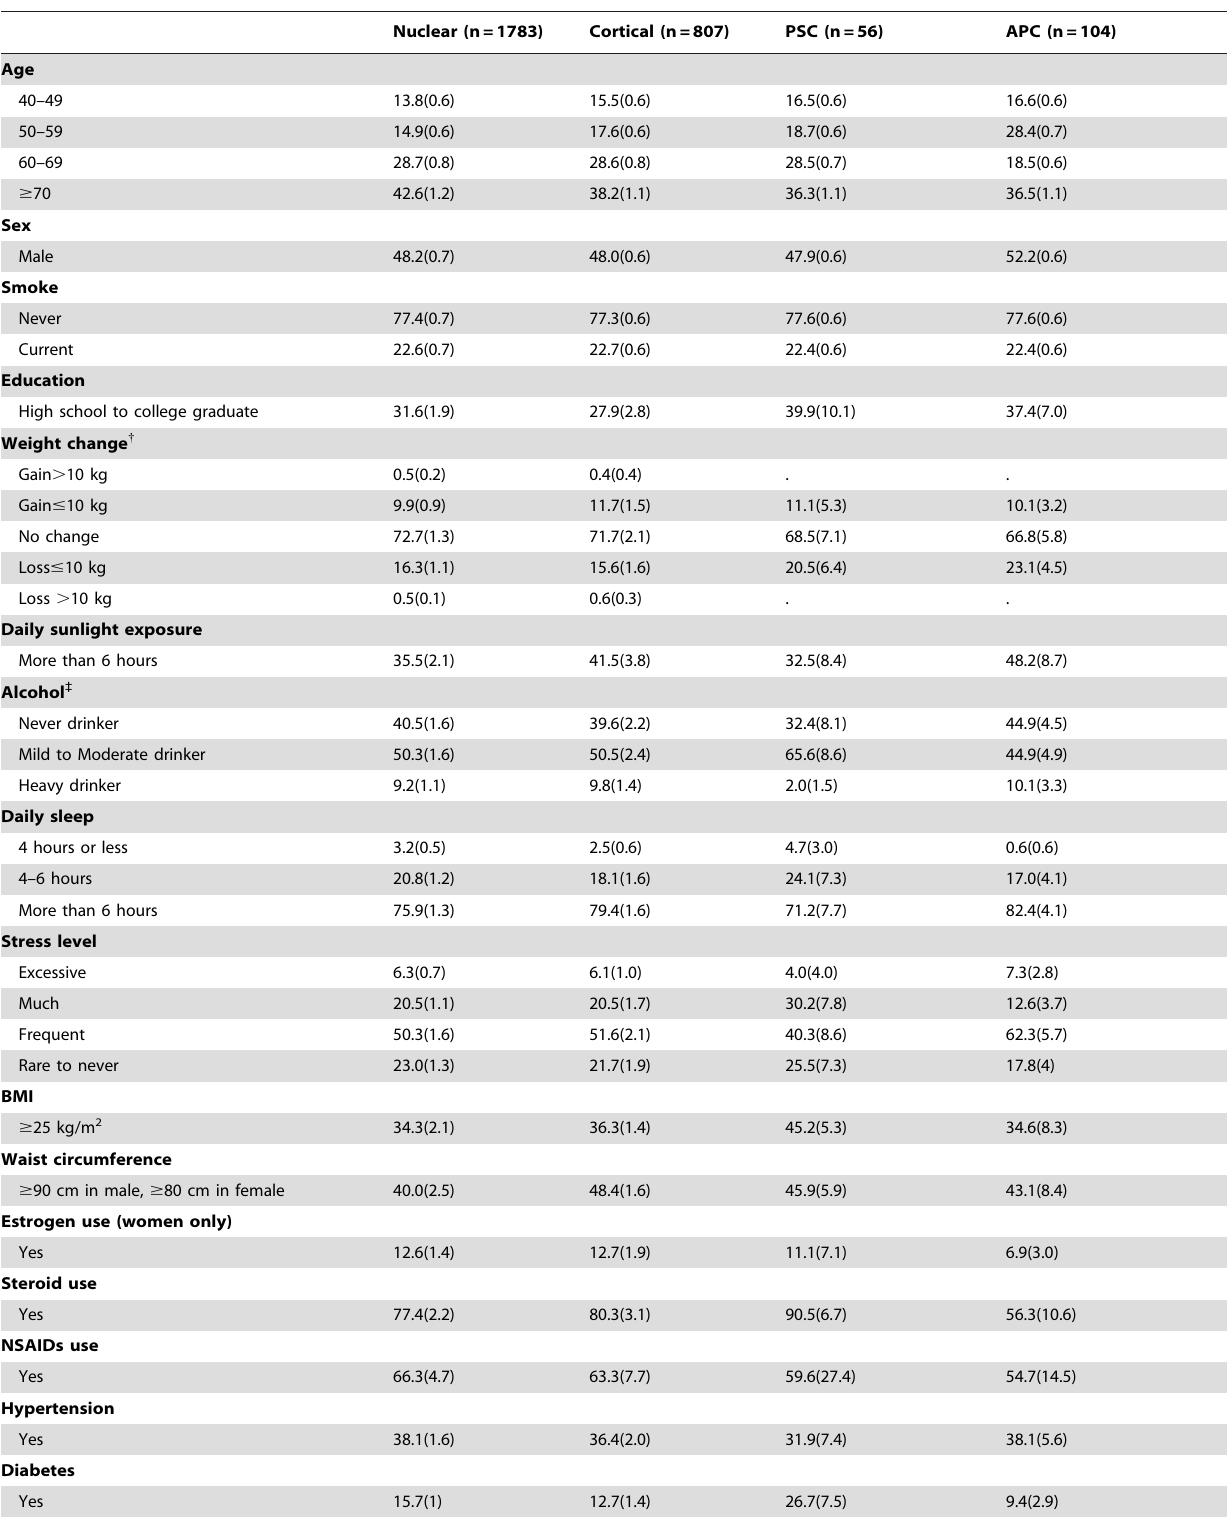
Table 1. Baseline characteristics of study